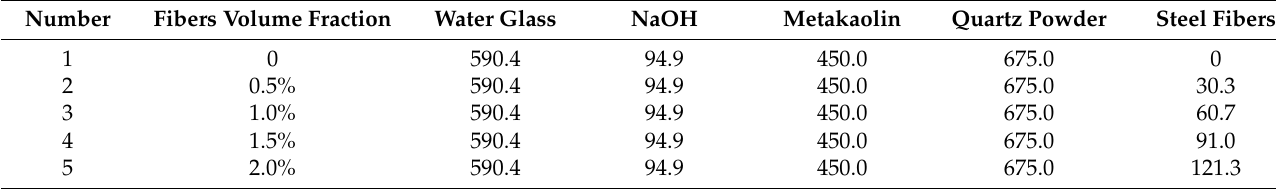
Table 4. Composition of HMGC with different fiber contents (unit: